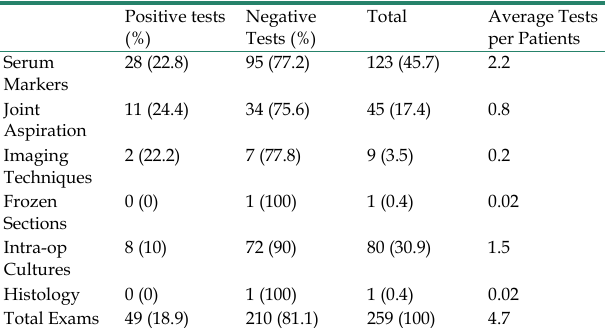
Table 3. Type, number and results (positive or negative) tests performed in patients eventually treated as non-infected (Group B,